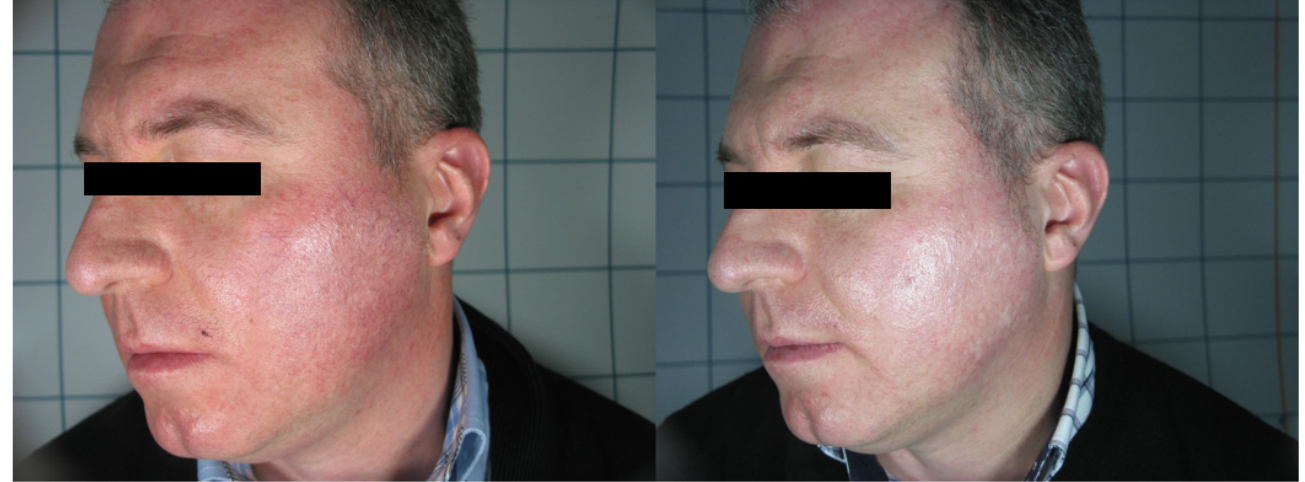
Figure 5. Patient n. 46 before (left) and 3 months after IPL treatment.